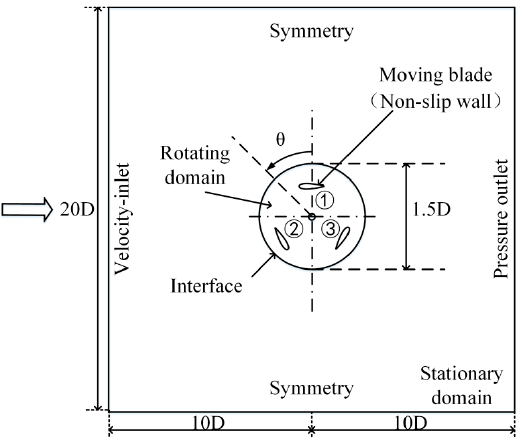
Figure 1. Schematic of different mesh zones in two-dimensional (2D) computational domain.